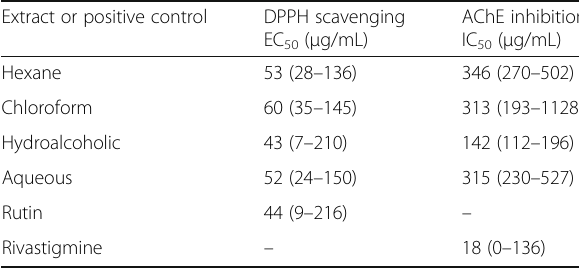
Table 2 DPPH radical scavenging and acetylcholinesterase inhibition by different extracts of Trichilia catigua Extract or positive control